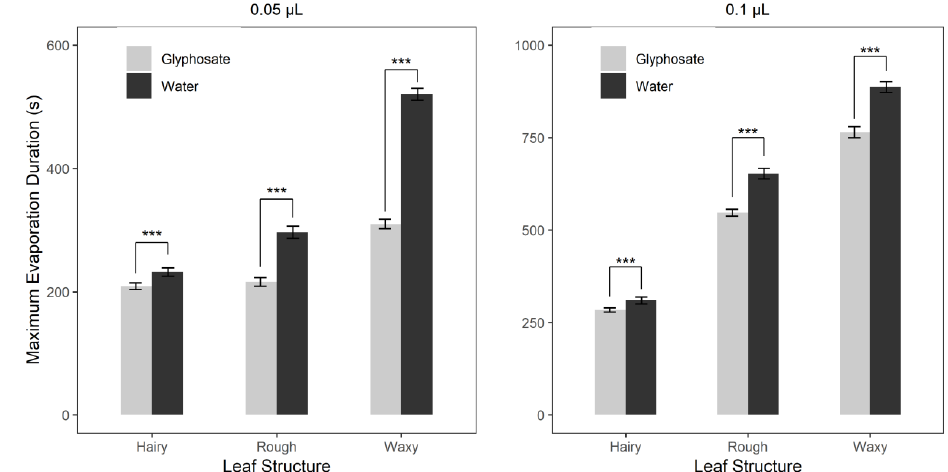
Figure 5. The maximum evaporation duration of droplets without the surfactant additives on di ff erent leaves and in di ff erent sizes. Spreading results of the droplet with 0.05 µ L and 0.1 µ L are shown (left and right side, respectively). “s” in the Y-axis name represents for the time unit seconds. The mark “***” represents the significant di ff erence of the values between each treatment according to the honest significant di ff erence (HSD) Tukey’s Test ( p < 0.001). For the leaf structure, the group names Hairy, Rough and Waxy represent the leaves of D. sophia, L. temulentum and L. lotifolium respectively .